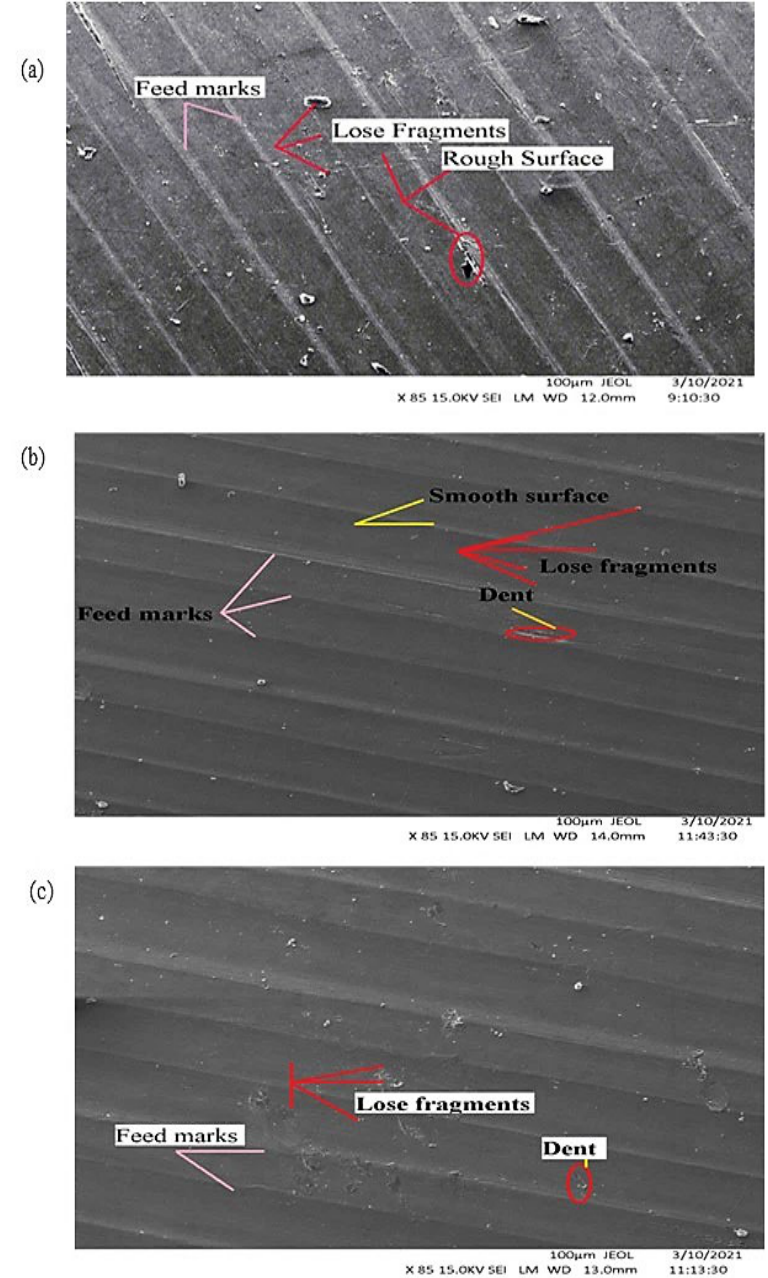
Figure 15. SEM pictures of surface machined at cutting speed of 150 m/min. ( a ) Dry cutting; ( b ) Compressed air; ( c )